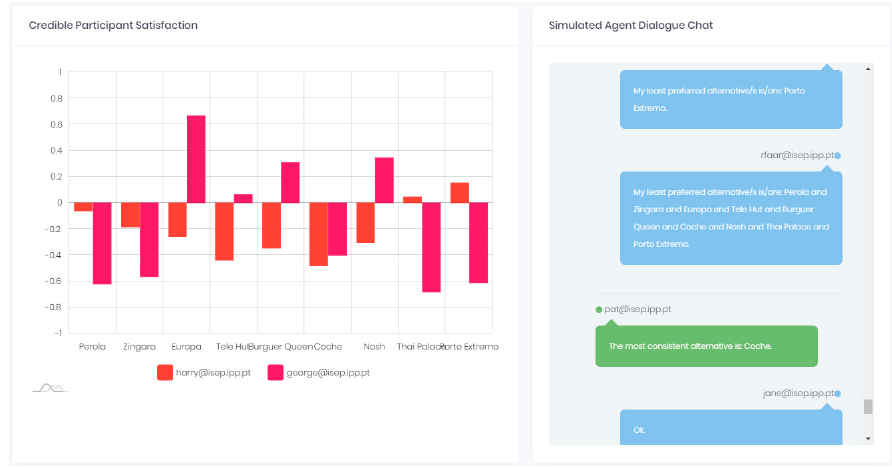
Figure 6. Elements of the “Personal Information” screen.